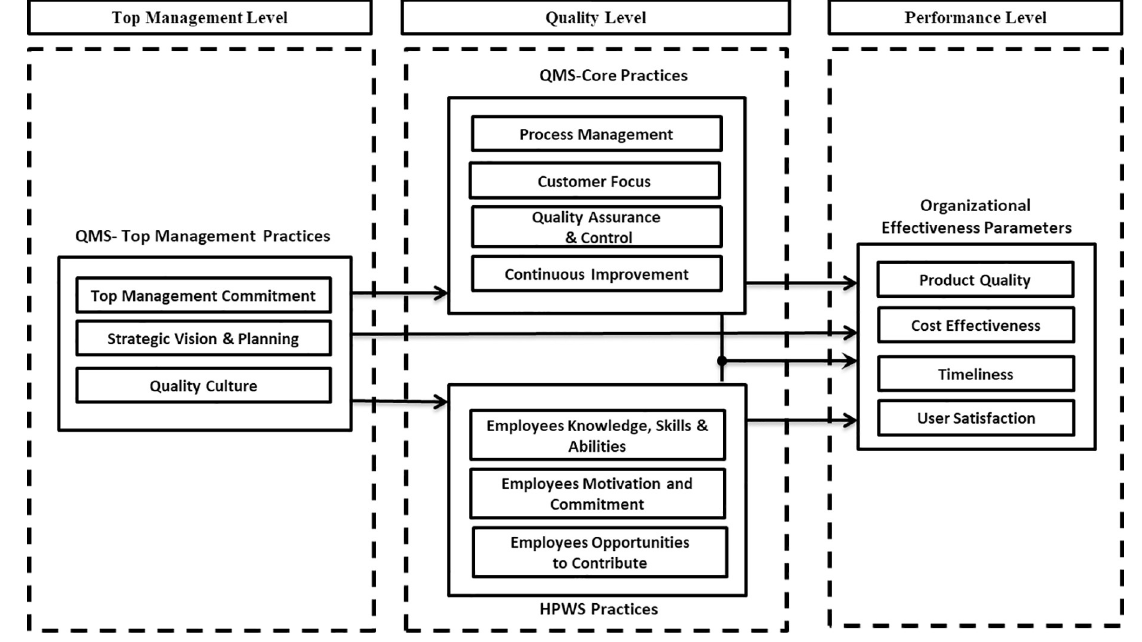
Fig 1. Theoretical framework of relationship between QMS, HPWS and OE